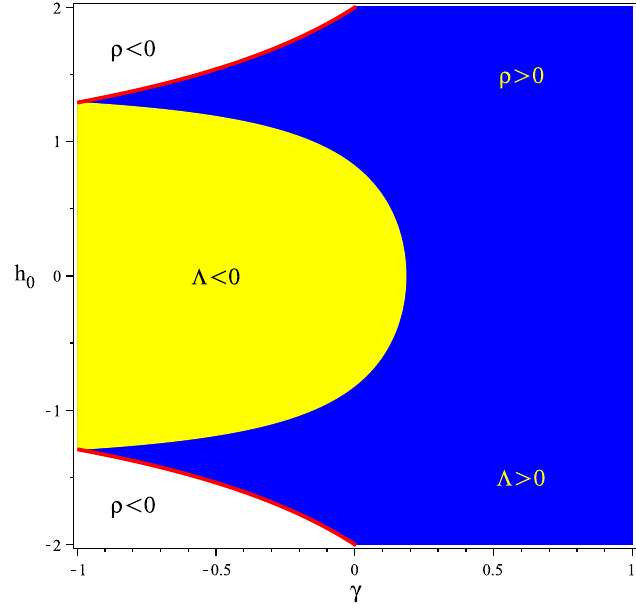
Figure 2. FRW model with eff T µν = ( m ) T µν + ( φ ) T µν + ( H ) T µν + ( V ) T µν . Plot of the region R (colored area) where ρ 0 > 0 where γ ∈ ( − 1,1 ] and h 0 ∈ [ − 2,2 ] . Yellow color means Λ < 0, while in the blue area, Λ >